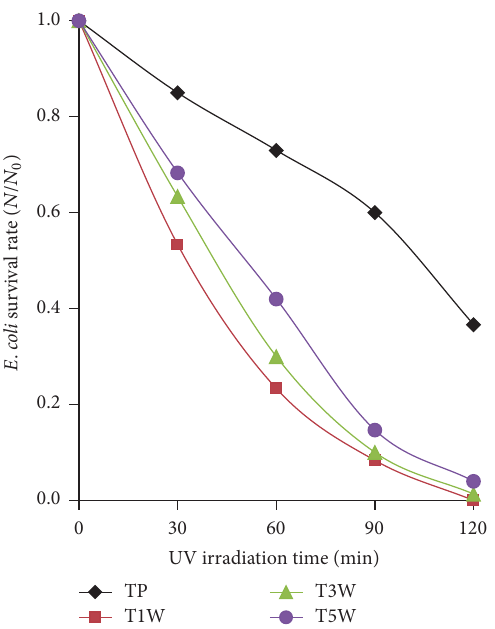
Figure 6: The antibacterial activity of WO 3 -doped TiO 2 coated CA.